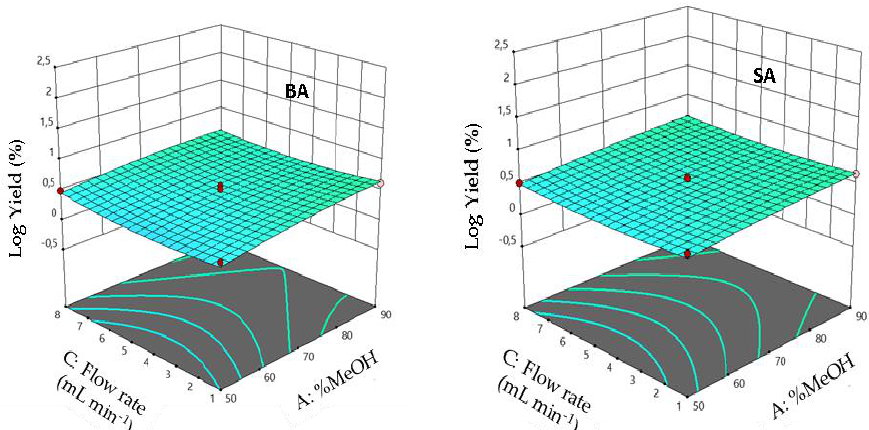
Figure 9. Response surface plots showing the effect of solvent volume and flow rate on elution efficiency. MeOH percentage is fixed at the optimum ( left ) R rBA and ( right ) R rSA .